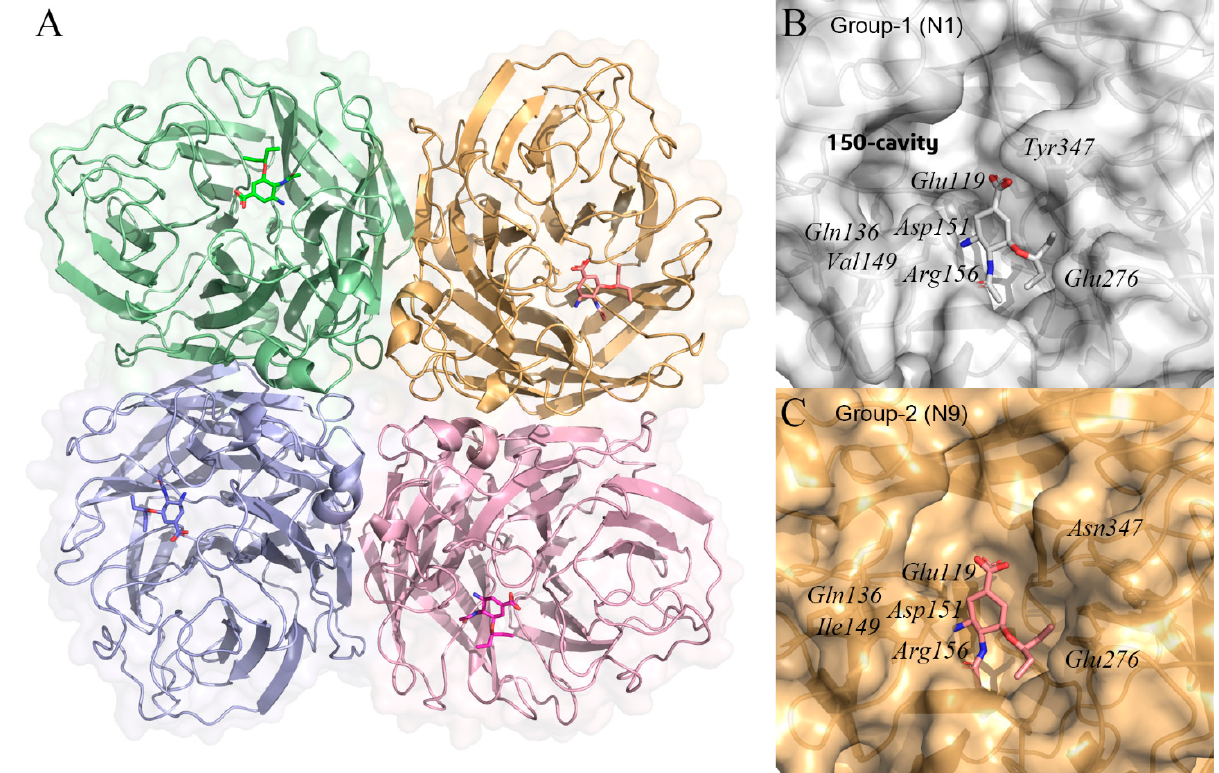
Figure 5. ( A ) structures of the influenza A virus neuraminidase tetramer with oseltamivir (PDB ID: 2HU4) [89]. Each monomer in the neuraminidase tetramer is represented as a different colored surface. Oseltamivir binds to the active site of neuraminidase and is shown in stick form. ( B , C ) molecular surfaces representation of group-1 (N1) (PDB ID: 2HU4) and group-2 (N9) neuraminidases (PDB ID: 5L15) [90] with oseltamivir. In group-1 neuraminidase has a distinct 150-cavity formed by 150-loop. The protein structure was displayed and analyzed through the PyMOL visualization program [69–71].